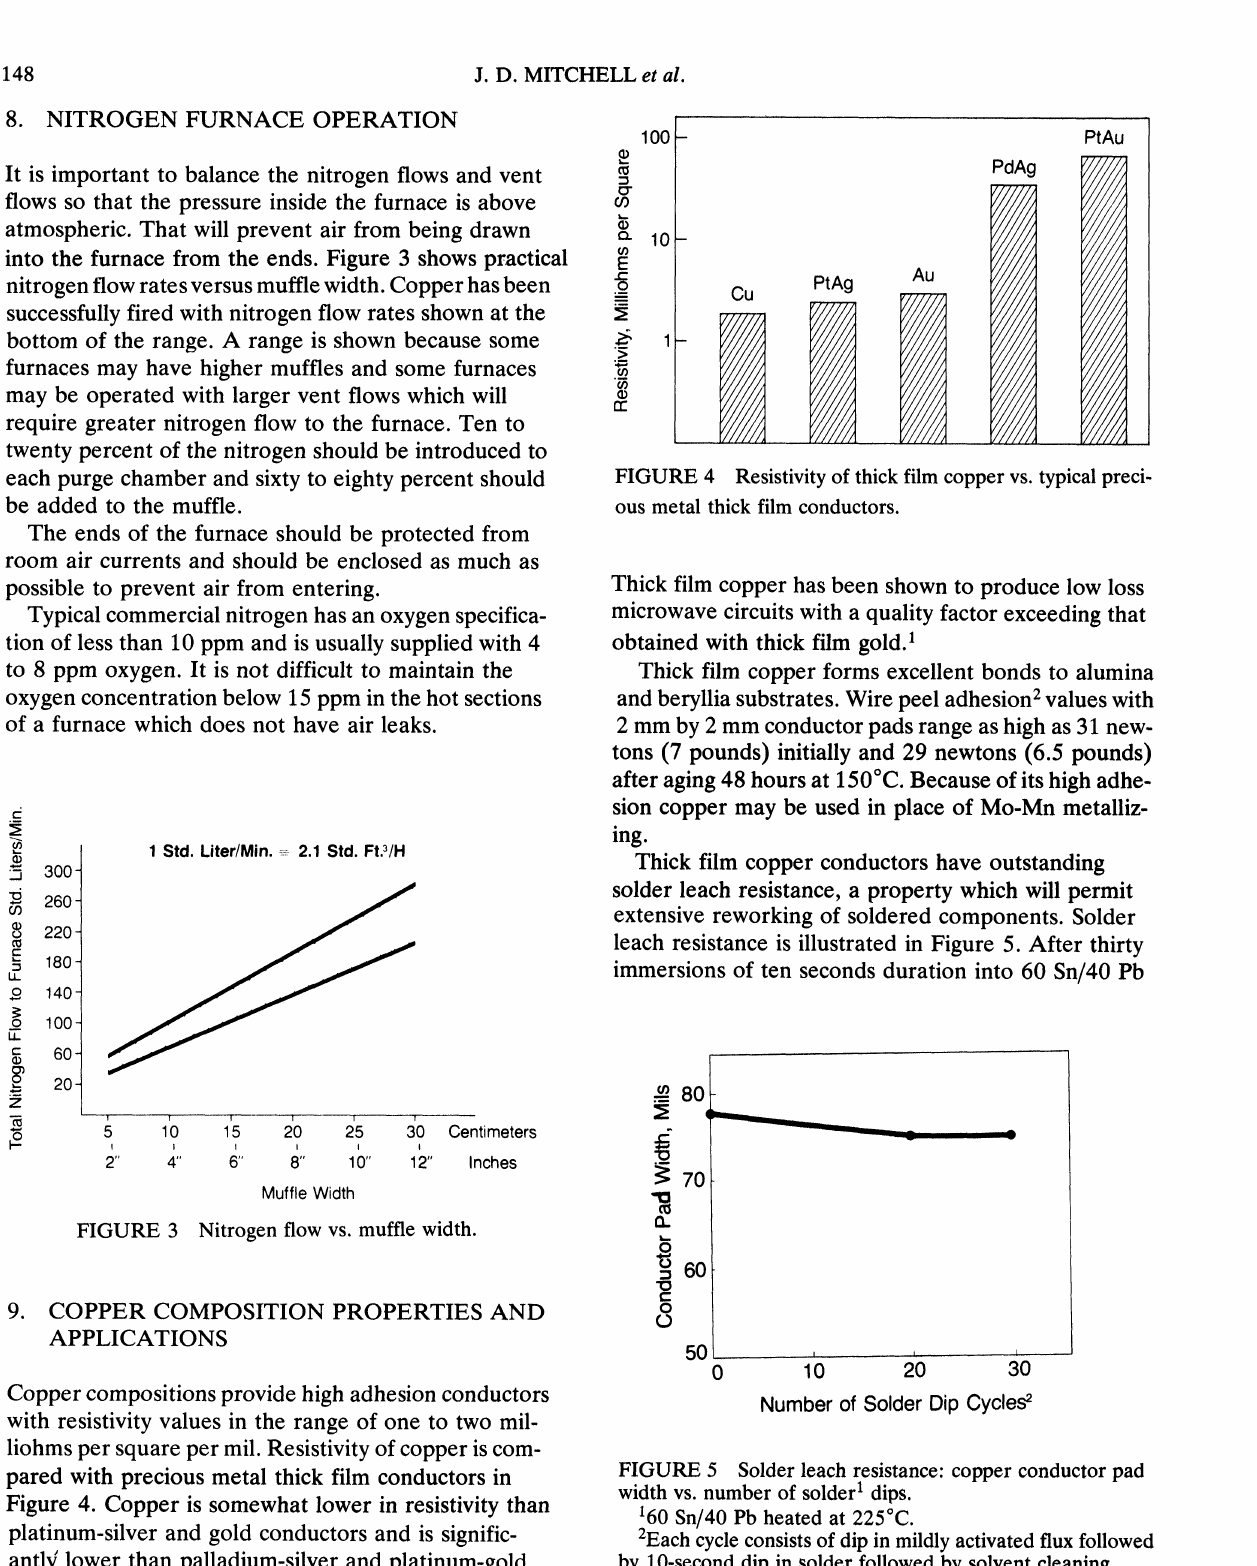
FIGURE 5 Solder leach resistance: copper conductor pad width vs. number of solder dips. 160 Sn/40 Pb heated at 225C. 2Each cycle consists of dip in mildly activated flux followed by 10-second dip in solder followed by solvent